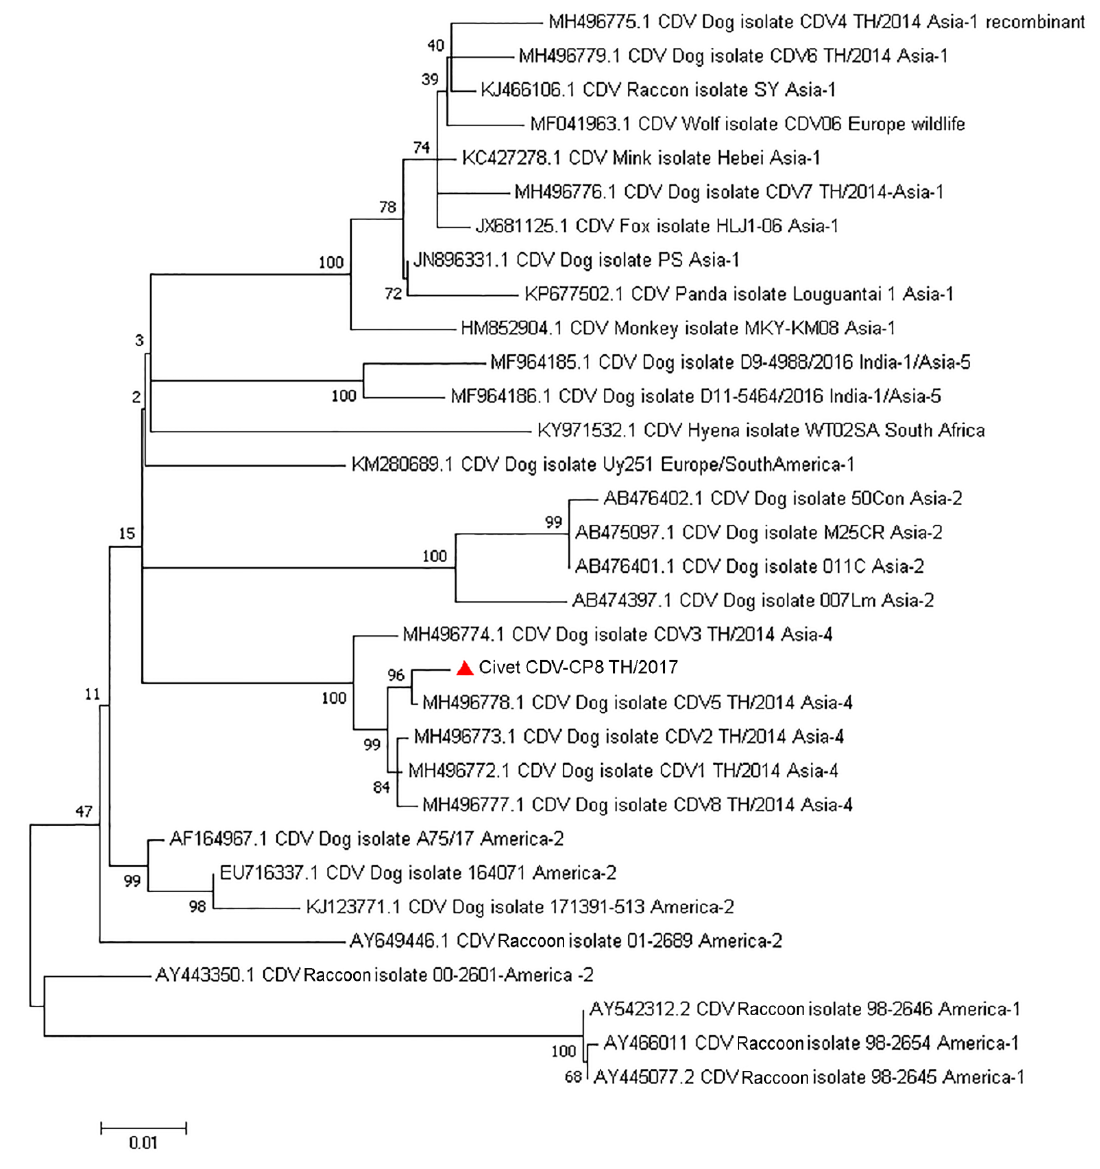
Figure 2. Phylogenetic analysis of the civet CDV strain in this study. Phylogenetic trees were based on the full-length CDV genomes, which revealed that the civet CDV-CP8 TH/2017 ( ▲ ) isolated in Thailand clustered with the CDV Asia-4 lineage. Bootstrapping results for 1000 replications with values greater than 50% are shown for each node . CDV (canine distemper virus).